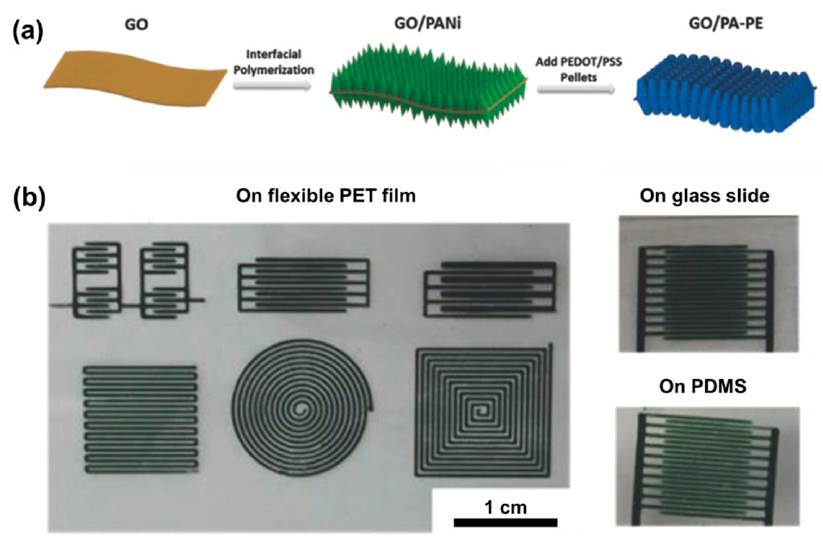
Figure 7. ( a ) Schematic illustration of the preparation of the composite inks. ( b ) Digital photographs of extrusion printed patterns on various substrates. Reproduced with permission from Reference [112].